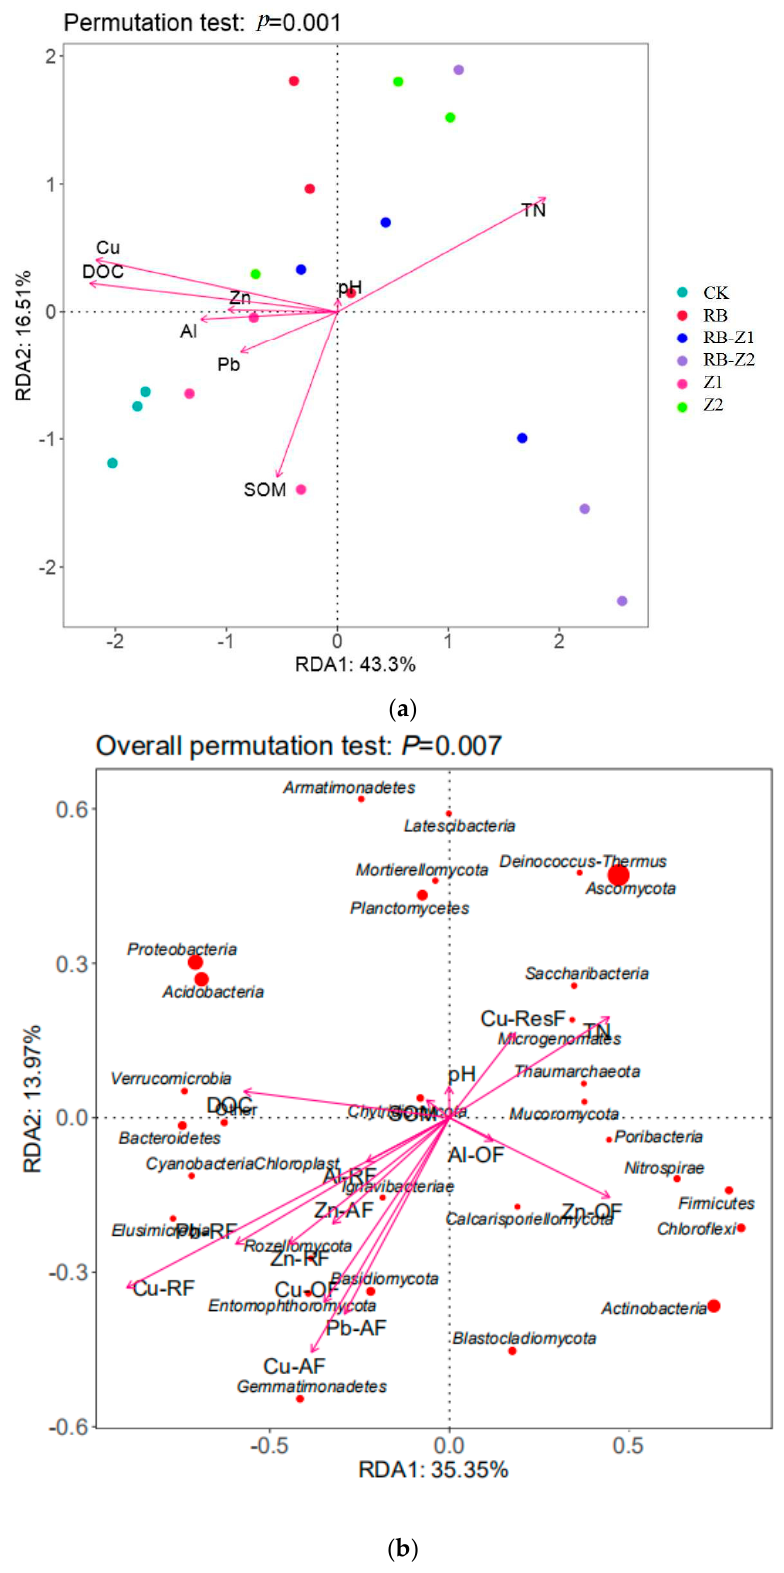
Figure 7. Redundancy analysis (RDA) of samples based on physicochemical characteristics. ( a ) correlation analysis between groups and physicochemical characteristics under different treatments. ( b ) correlation analysis between bacterial and fungal communities and physicochemical characteristics.